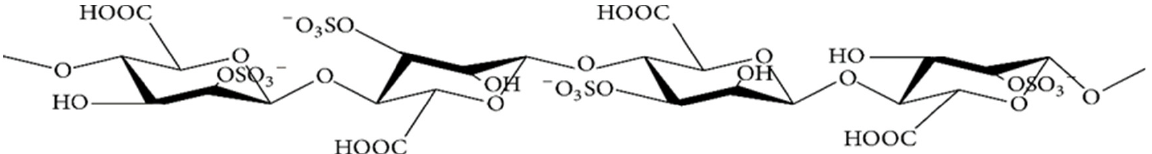
Figure 2. Chemical structure of sulfated polymannuroguluronate (SPMG).